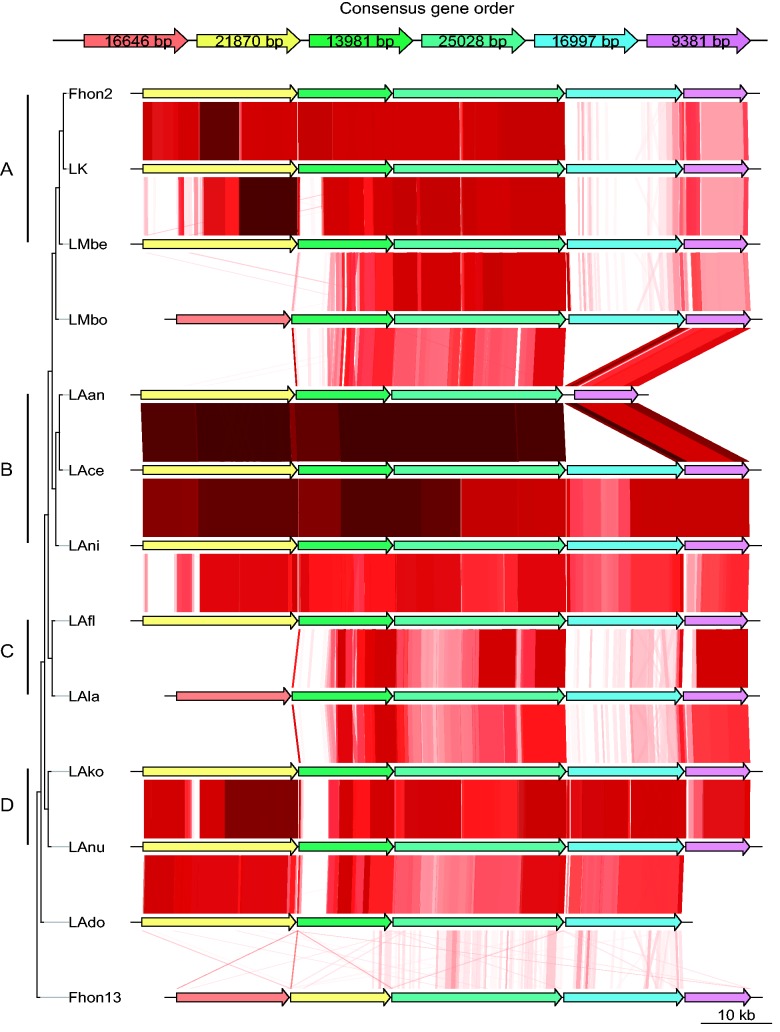
Gene order structures of the segment coding for giant extracellular proteins. Each arrow represents a gene inferred to code for a giant protein, with colors representing distinct protein orthologs. Red lines are shown for tBLASTx hits with more than 50% identity over more than 100 amino acids. White spaces represent either absence of BLAST hits or hits below the established thresholds. Shown at the top is the consensus order of genes and their average lengths. The tree topology and the microclusters (letters A–D) are as in figure 1b.